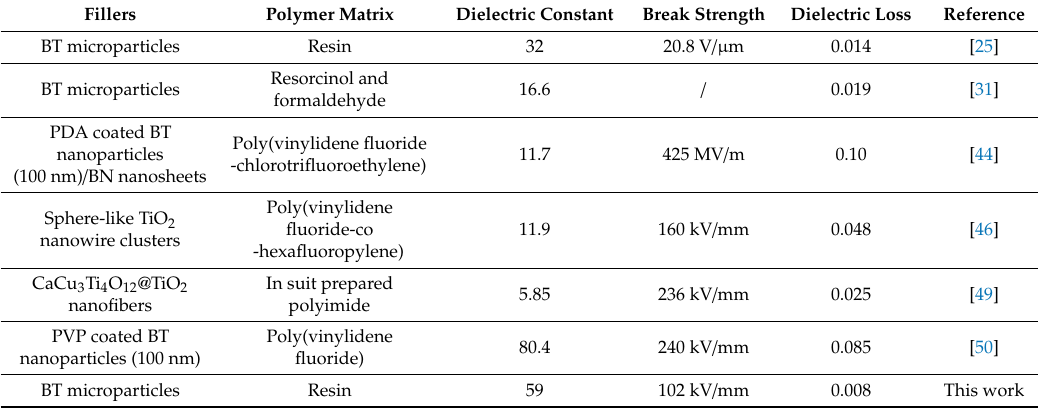
Table 2. Comparisons of dielectric constant, dielectric loss and breakdown strength of the composites containing BT particles.